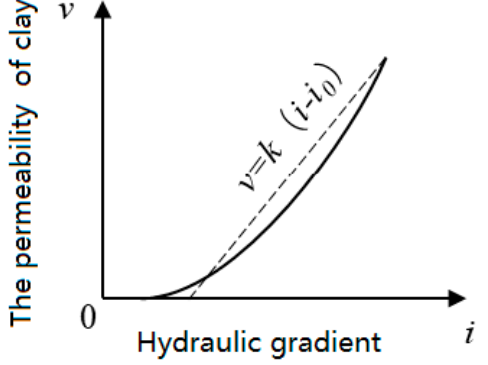
Figure 3. Relationship between the permeability rate of clay and the hydraulic gradient.